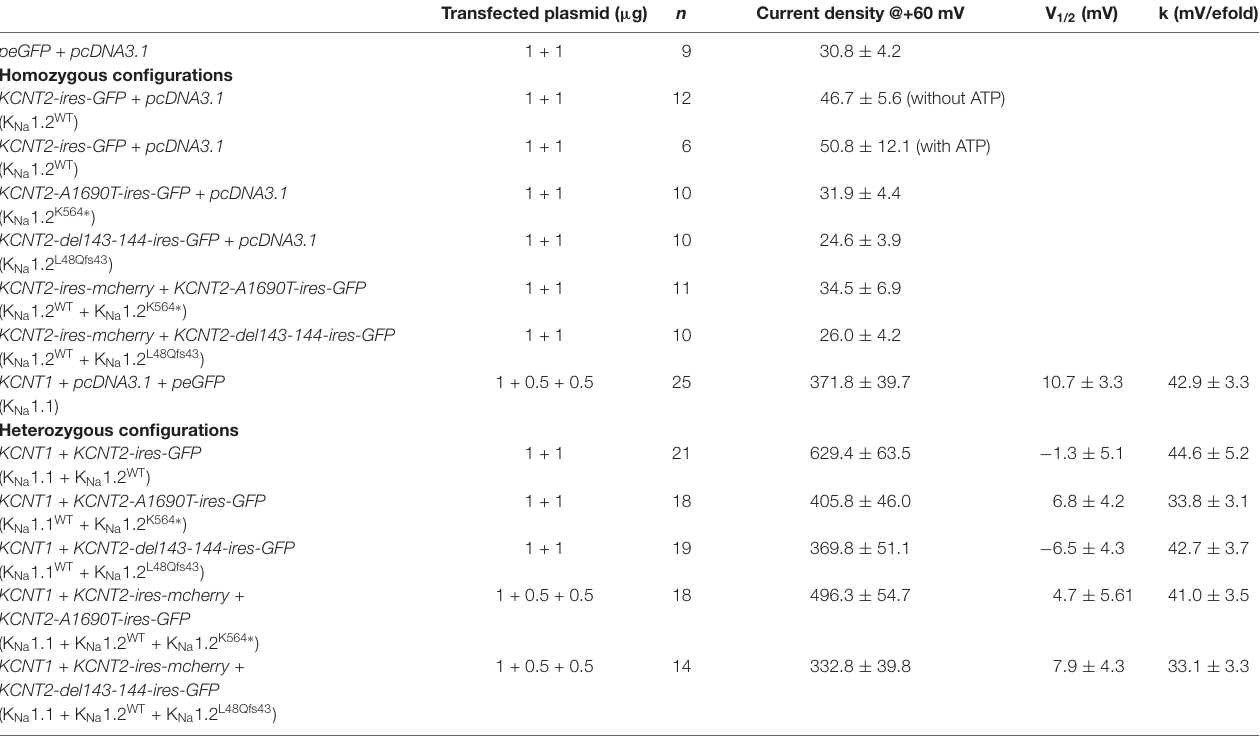
TABLE 1 | Biophysical properties of currents recorded in chinese hamster ovary (CHO) cells transfected with the following plasmid combinations. Transfected plasmid ( µ g) n Current density @+60 mV V 1/2 (mV) k (mV/efold) peGFP +